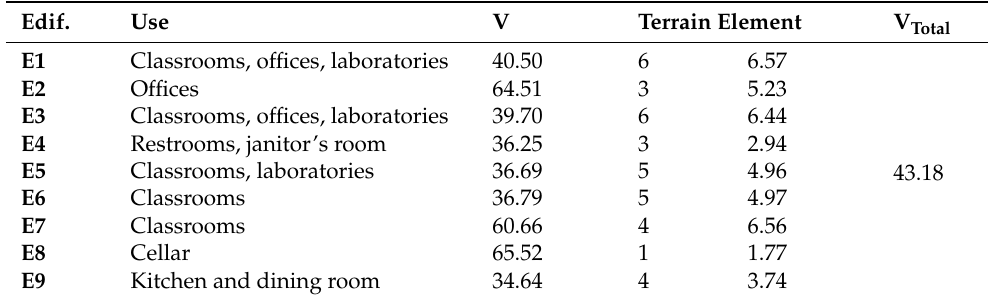
Table 12. Summary of building evaluation and total vulnerability of the school.